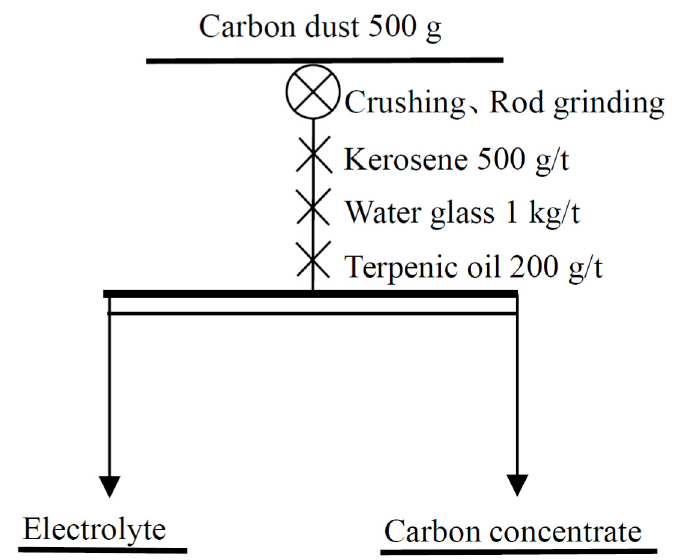
Figure 4. Flotation process for a single factor experiment.